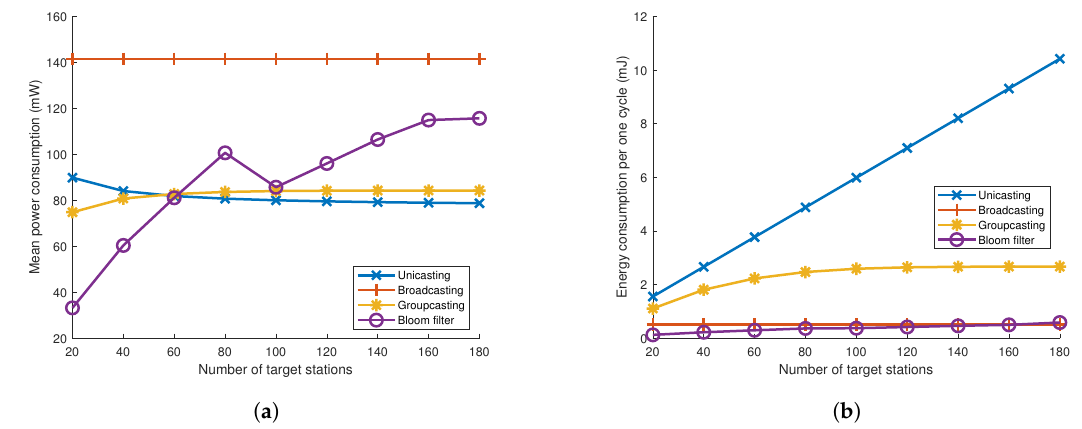
Figure 9. ( a ) Mean power consumption and ( b ) energy consumption until all targeted stations are waken up for each addressing mechanism.